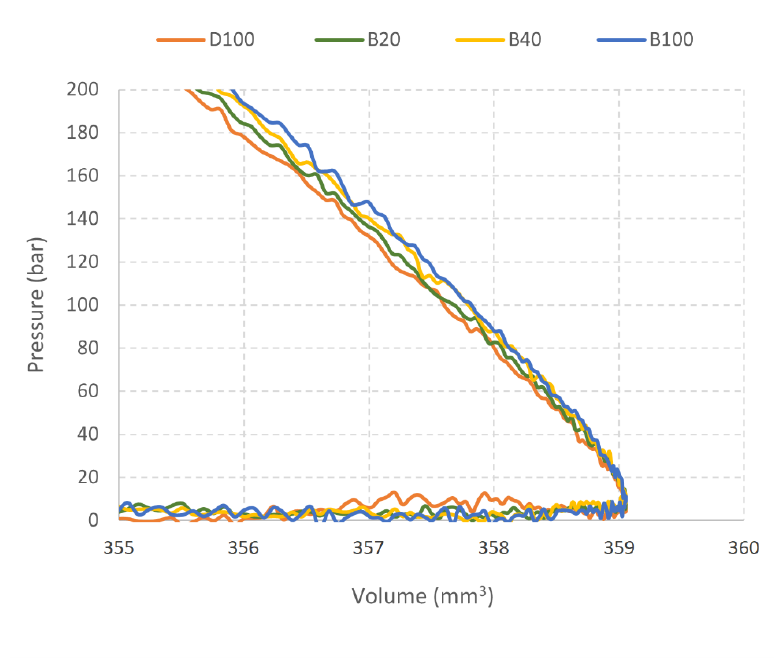
Figure 14. PWC diagrams for pure fluids and blends at 1500 RPM, MP.